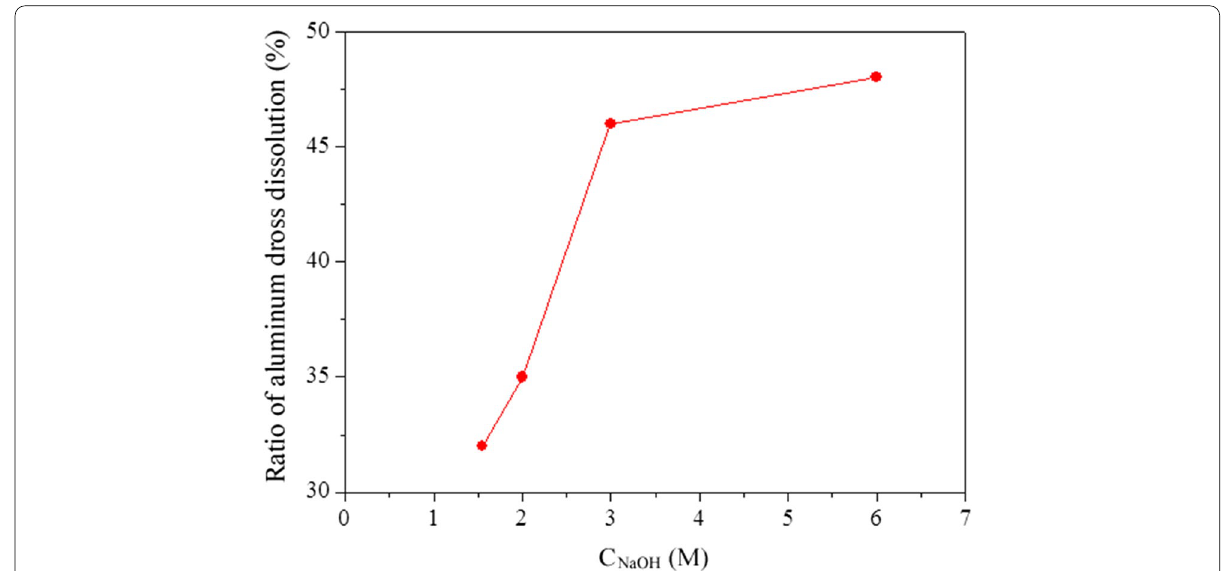
Fig. 6 Influence of NaOH concentration on aluminum substance dissolution